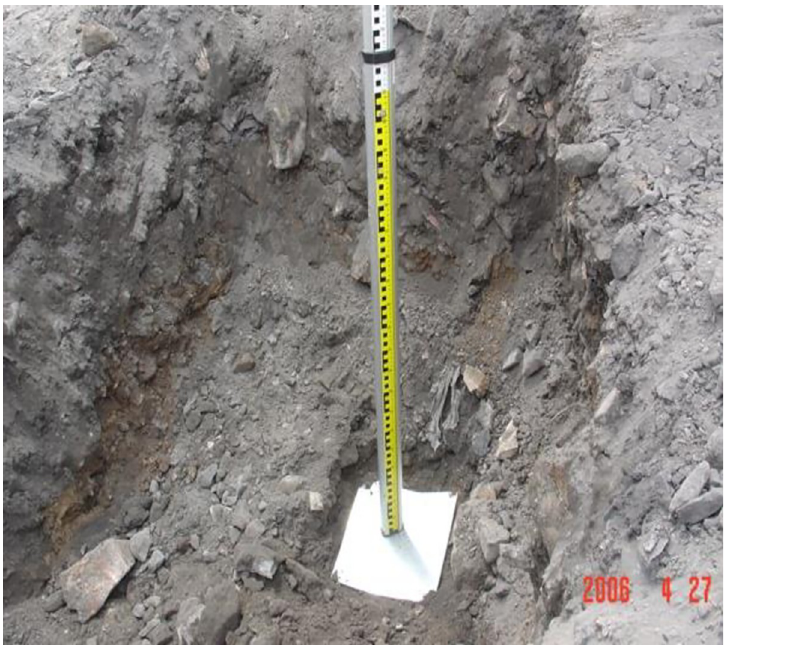
The measuring points for measuring tamping induced grain breakage are the same as the deformation measuring described in section 3.3. After tamping, the coal gangue was excavated, and screening test at the construction site was conducted and coal gangue gradation curves were obtained for different tamping energies.